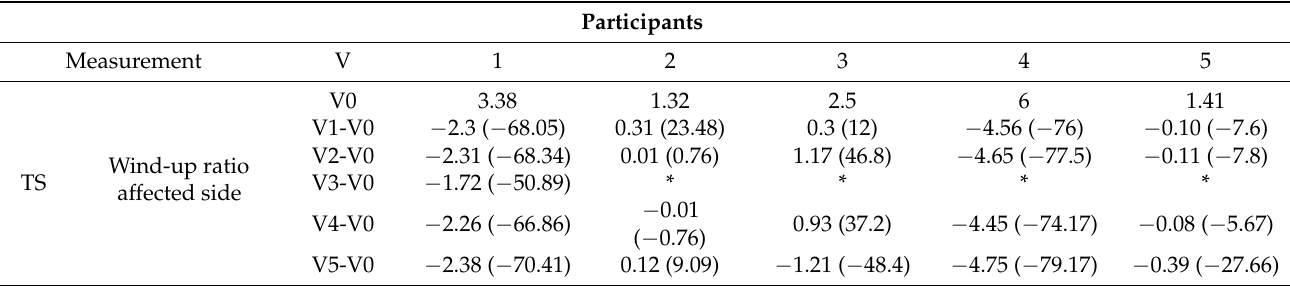
Table 3. Changes (percentage) in direct measurements scores: temporal summation, suprathreshold pressure stimulus, and vibration detection